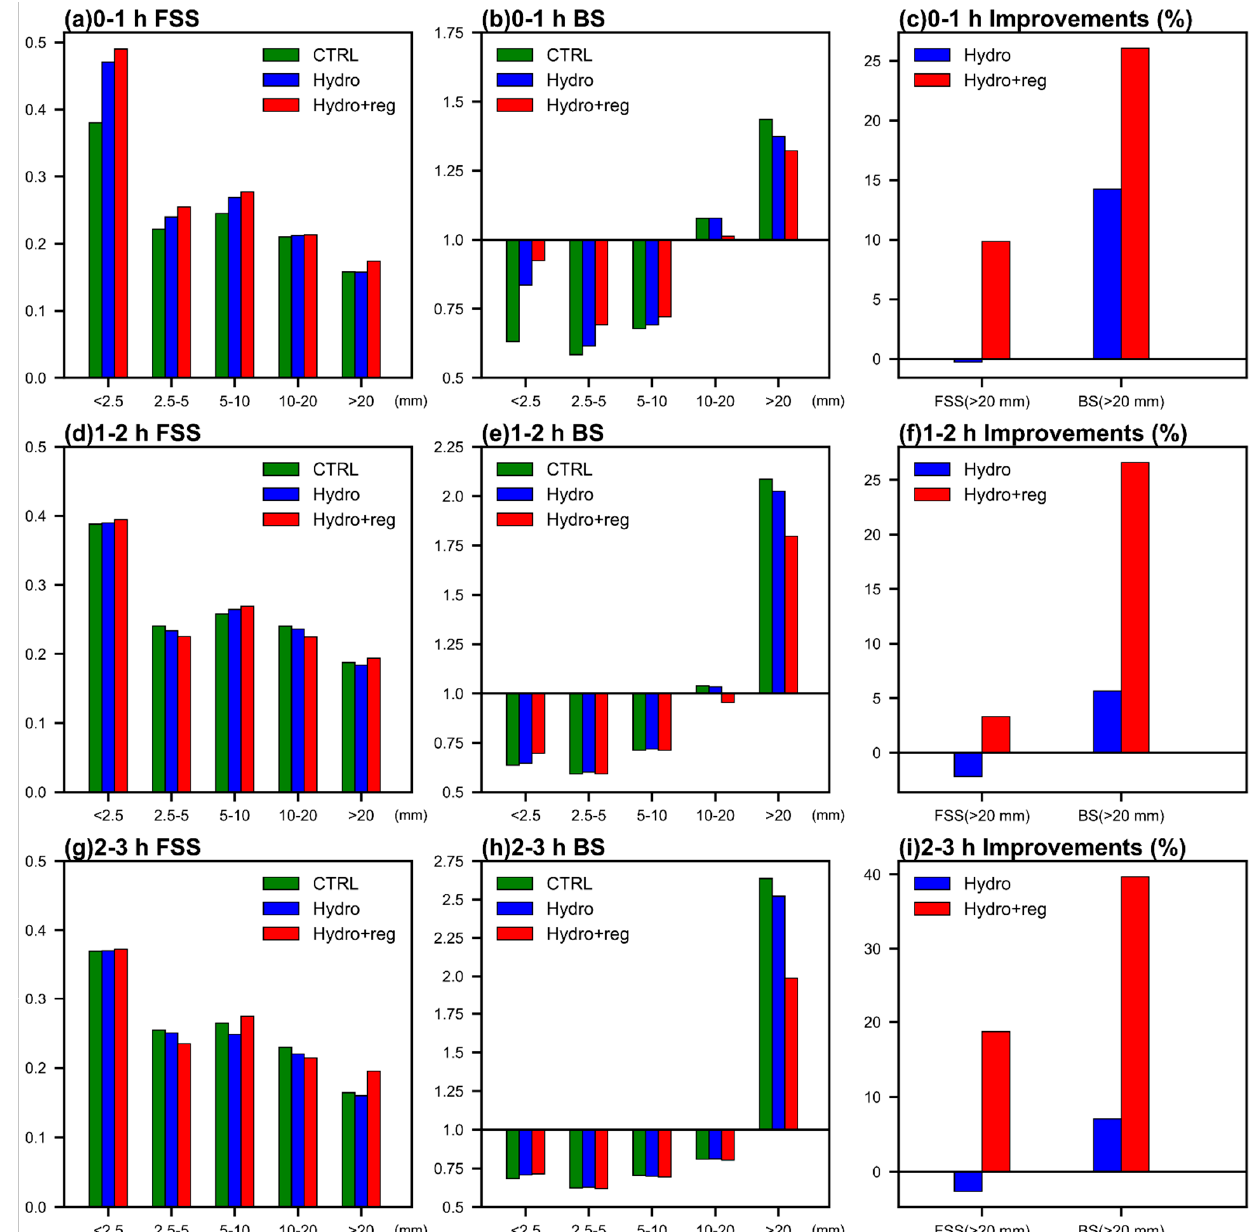
Figure 7. The 20-cycle-averaged FSS scores (the left column), BS scores (the center column) and improvements in the percentage compared to CTRL experiment (the right column) for each-hour precipitation forecast in main precipitation area from the 5 cases. ( a – c ) 0–1 h, ( d – f ) 1–2 h, ( g – i ) 2–3